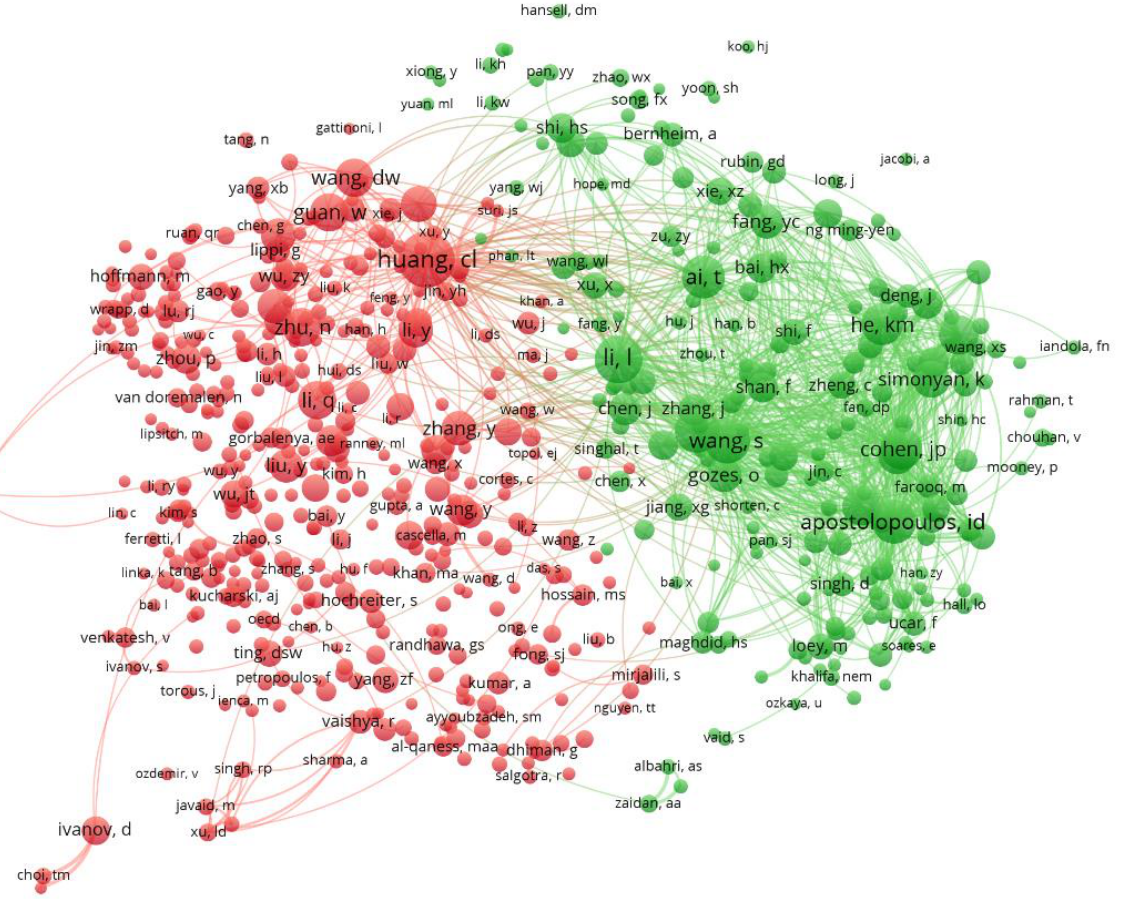
Figure 12. Co-citation mapping by authors (source WoS).